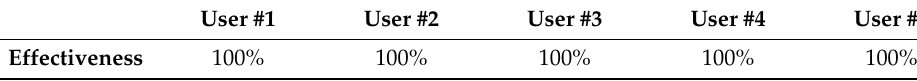
Table 1. Effectiveness results scored by each user.